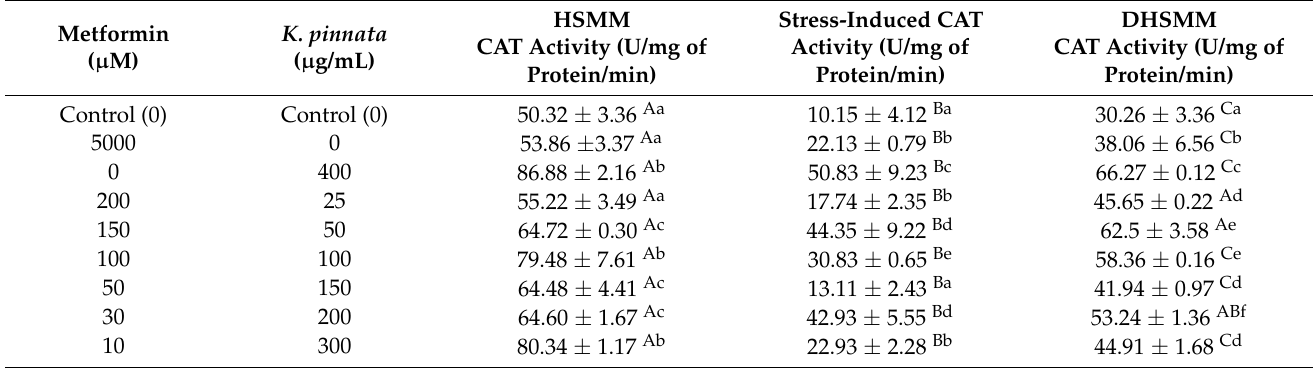
Table 5. Observed cellular catalase (CAT) activity in cells after 72 h of treatment. Data are presented as mean ± standard error of the mean. Significant differences are indicated by different letters (uppercase letters within row; lowercase letter within column for each treatment option) according to Tukey post hoc test ( p < 0.05): control (no treatment); human skeletal muscle myoblast (HSMM); diabetic human skeletal muscle myoblast